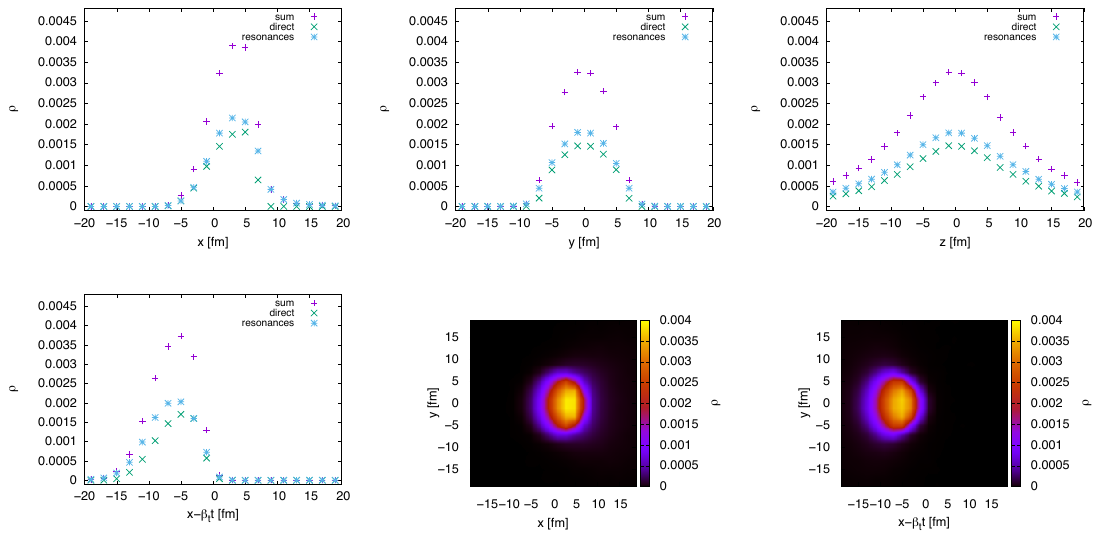
Figure 4. The spatial distribution of the emission points of pions for K T s. Upper row: The profiles of the emission points distribution along the x ( left ), y ( middle ), and z-axis ( right ). Lower row: The profile along the variable ( x − β t t ) ( left ), and two-dimensional distributions in the transverse plane ( middle and right ). A green × shows the profile of direct pions, a purple + shows the profile of pions produced by resonances and a blue ∗ shows their sum. All these distributions were calculated as narrow integrals over the remaining coordinates with width 2 fm.